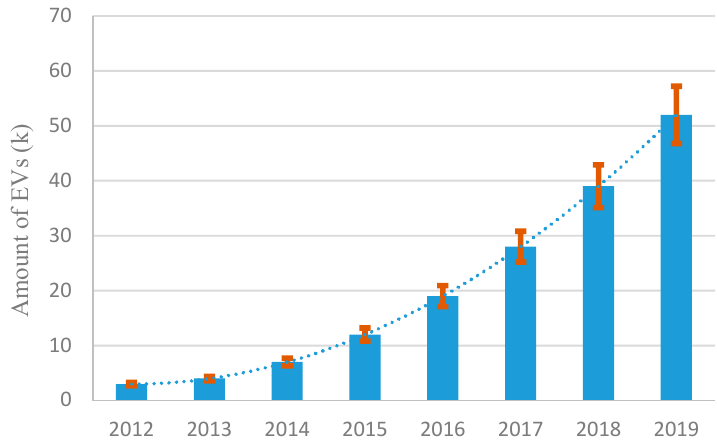
Figure 3. Growth curve of the amount of electric vehicles (EVs) in Hefei (±5% error).